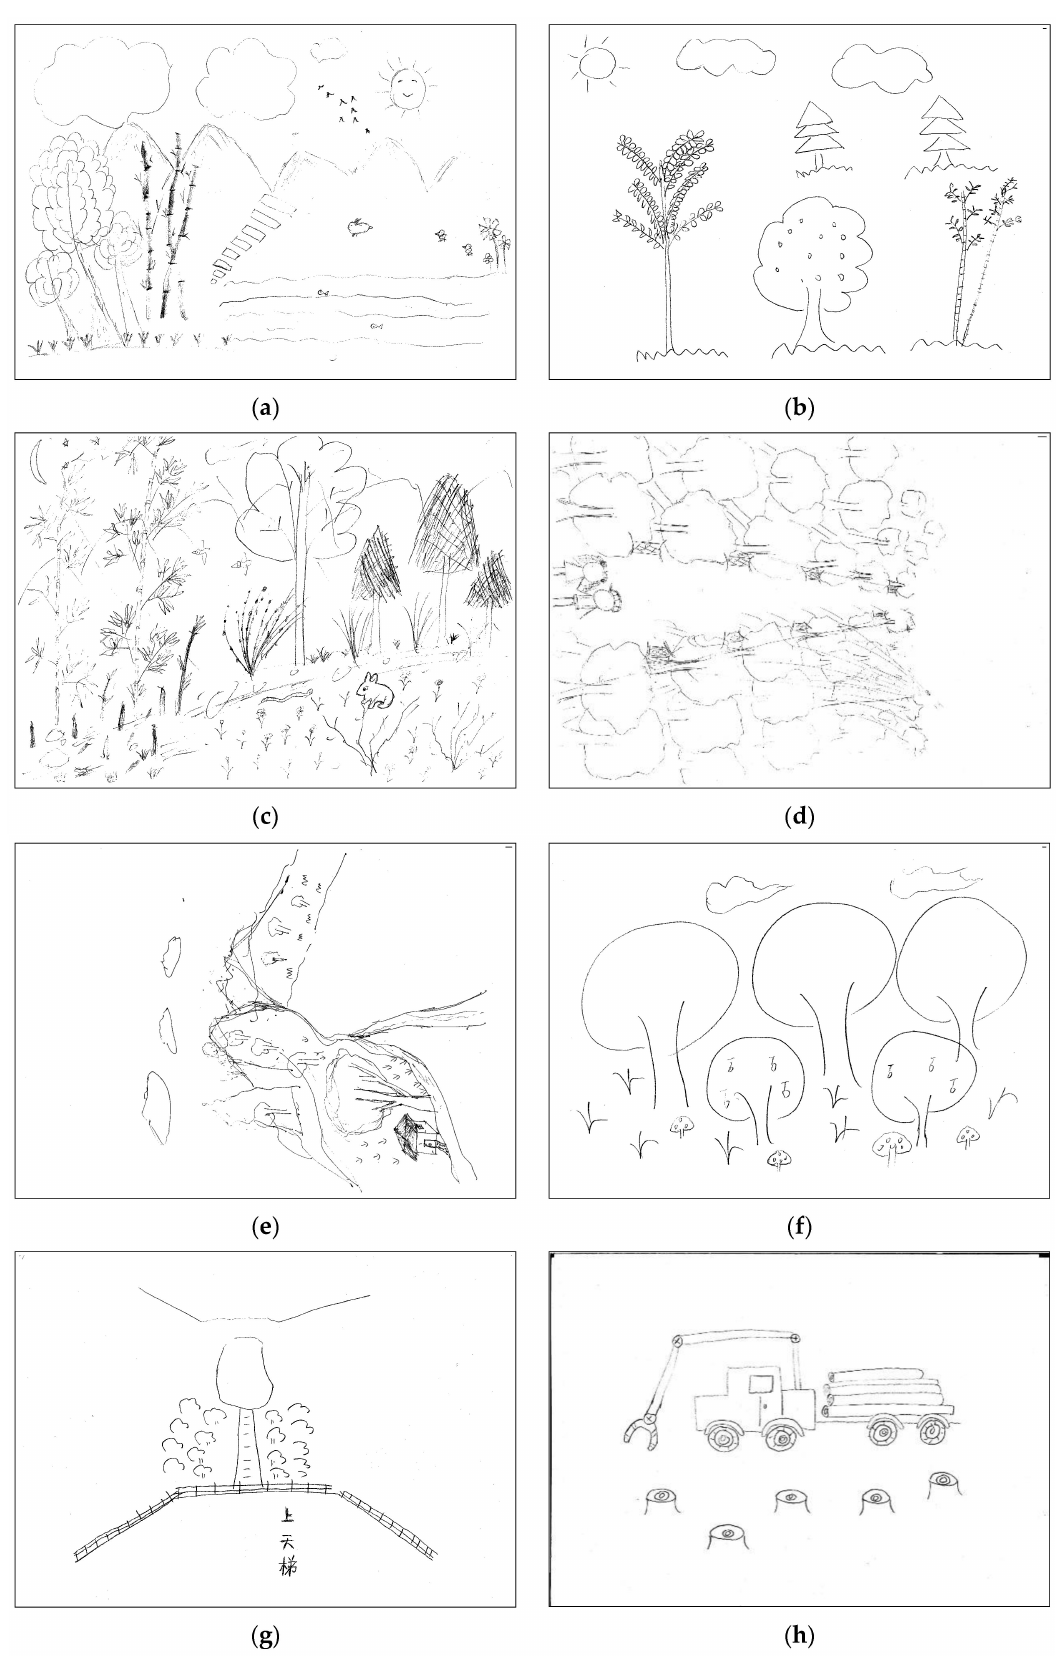
Figure 5. Classification of ‘social meaning’: ( a ) scenic view; ( b ) forest structure; ( c ) ecological system; ( d ) recreational space; ( e ) life world; ( f ) natural resources; ( g ) symbolic place; ( h ) forestry